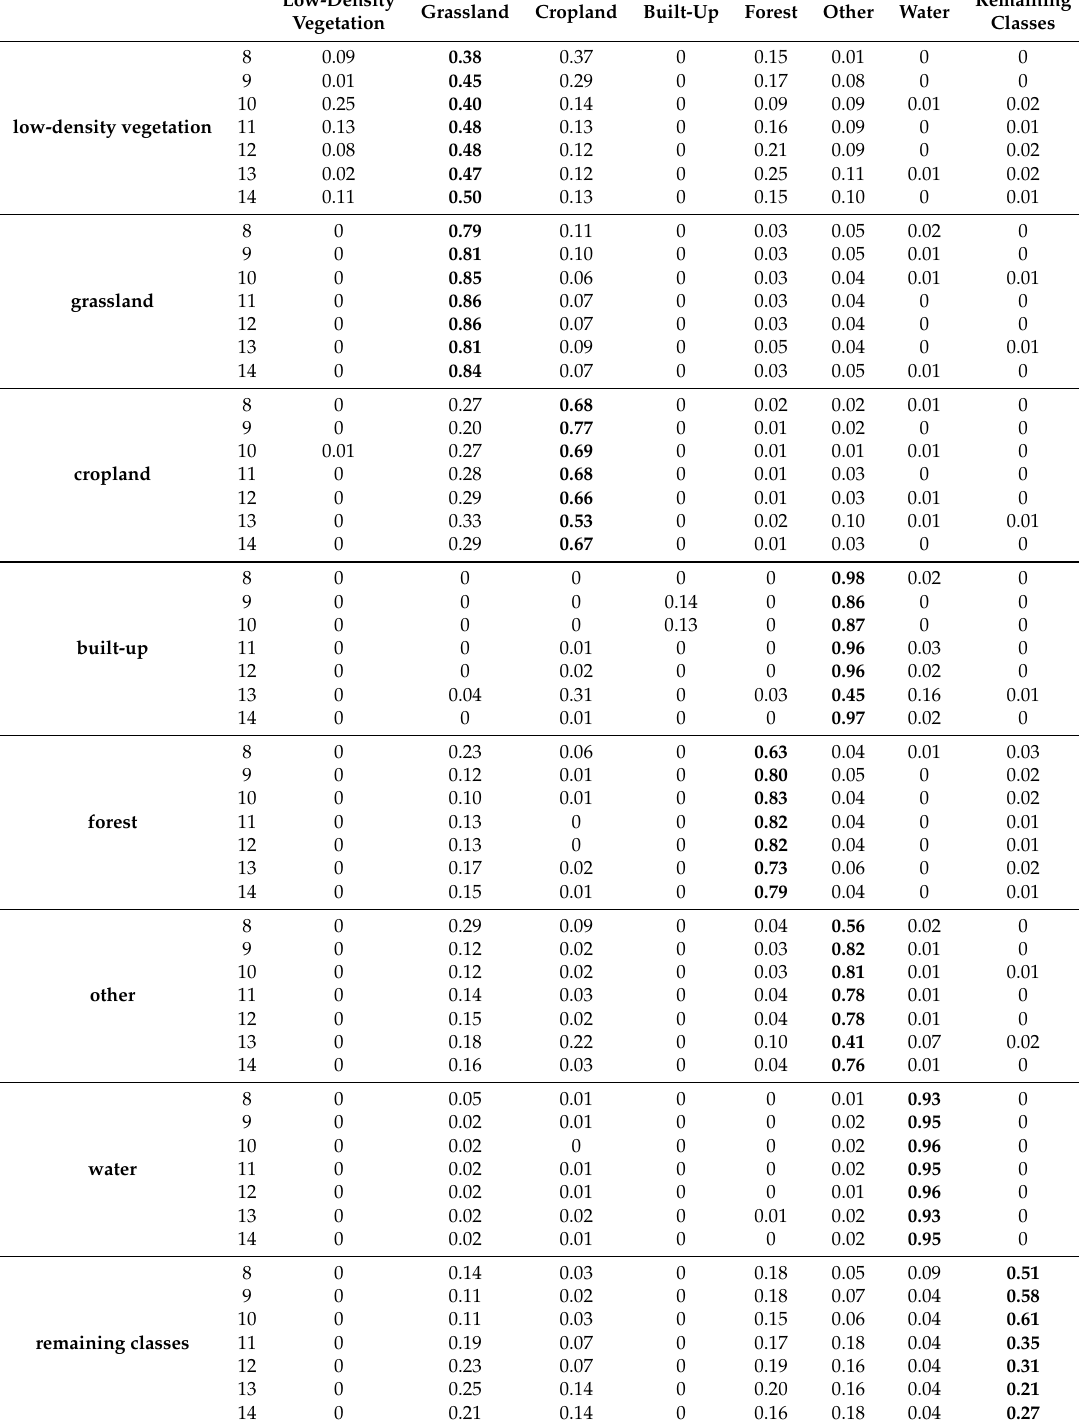
Table 5. Confusion matrix for selected